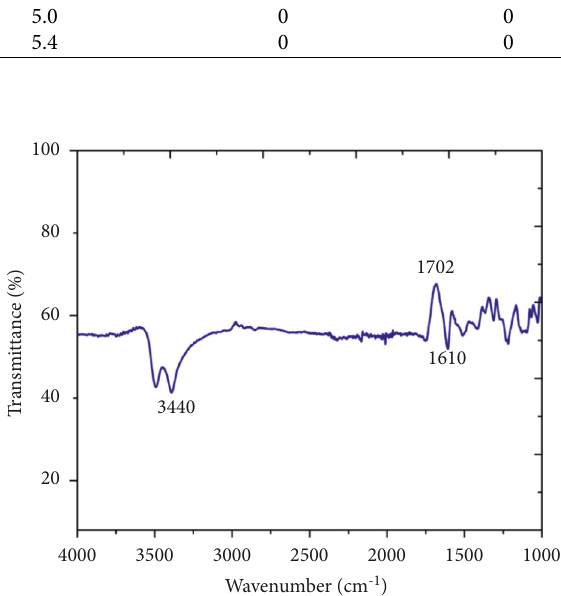
Figure 4: FTIR analysis of LDPE after 30days of inoculating it with fungal